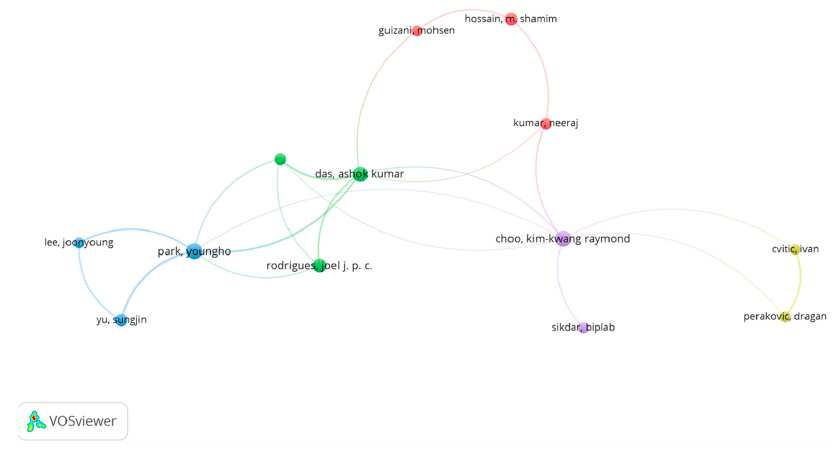
Figure 5. Co-authorship map of authors.